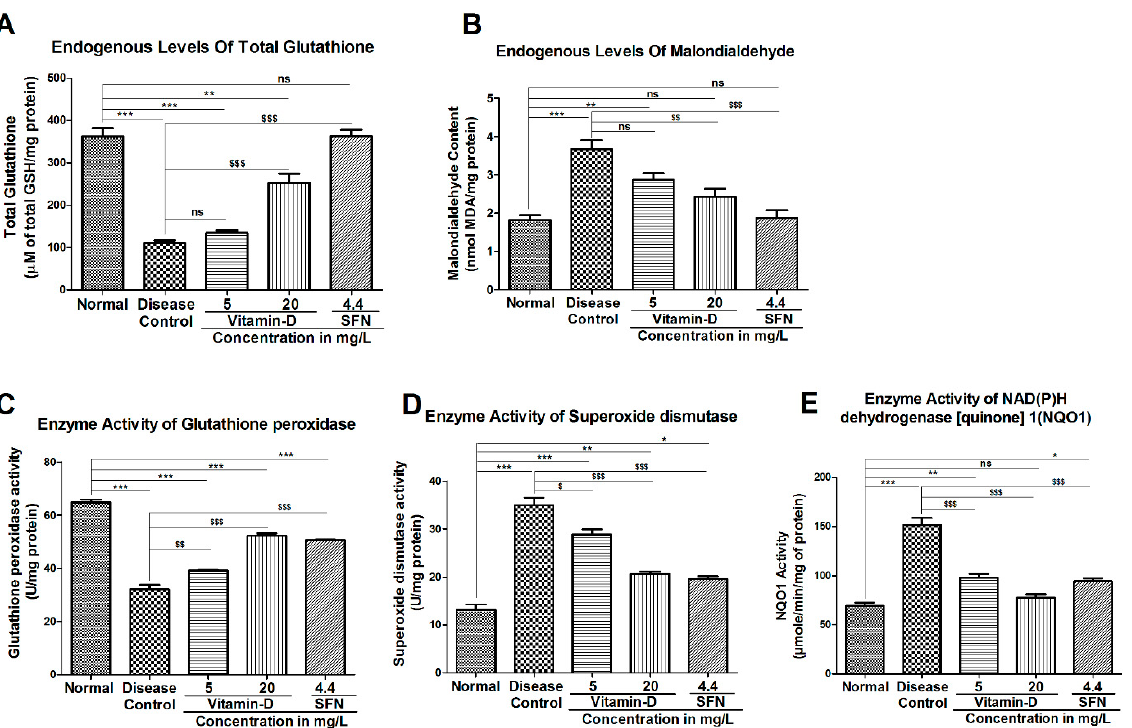
Figure 6. Hyperglycemia-induced oxidative stress markers were modified by vitamin-D and sul- foraphane. ( A , B ) Vitamin D and SFN could mitigate the hyperglycemia-induced changes in the reduced-glutathione (GSH) and malondialdehyde (MDA) levels in zebrafish. Hyperglycemia has decreased the endogenous glutathione level in zebrafish compared with normal control ones. Treatment with vitamin D and SFN moderately increased the GSH level in hyperglycemia zebrafish ( A ). The oxidative stress marker MDA (a product of lipid peroxidation) has increased in the hyperglycemia zebrafish. Elevated MDA level was decreased by the treatment with vitamin D and SFN ( B ). The “***” & “**” represents a significant difference compared with that of normal control group with p < 0.0001 & <0.05. “$$$” & “$$” Represents a significant difference compared with that of the disease control group with p < 0.0001 & <0.05. ‘ns’ represents a non-significance. ( C – E ) Treatment with vitamin D and SFN modulated the activity of glutathione peroxidase (GPX), superoxide dismutase (SOD) and NADPH quinone oxidoreductase 1 (NQO1) in zebrafish. Hyperglycemic state has reduced the GPX while increasing SOD and NQO1 activity in zebrafish ( C – E ). Treatment with vitamin D and SFN has increased the GPX level while decreasing diabetes-induced SOD and NQO1 activity. The data represents mean ± SEM. The results were analyzed by one-way ANOVA, followed by Tukey’s post-hoc test, used for multiple comparisons. The “***”, “**” & ‘’*”represents a significant difference compared with that of the normal control group with p < 0.0001, <0.001 & <0.05. “$$$”, “$$” & ‘’$” Represents a significant difference compared with that of the disease control group with p < 0.0001, <0.001 & <0.05. ‘ns’ represents